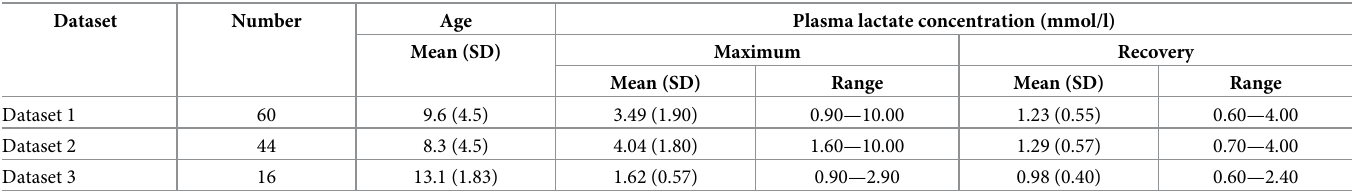
Table 1. Number, age (in years), and plasma lactate concentration (post-SET and the maximum value during SET) of horses by datasets.